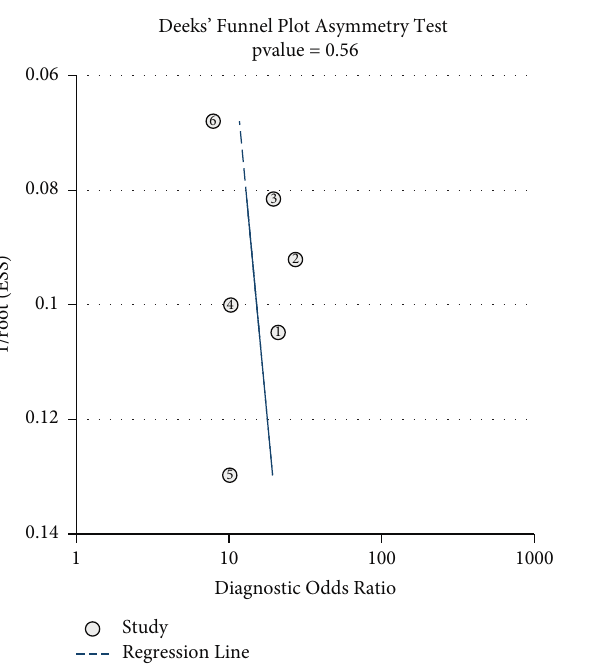
Figure 4: Publication bias evaluating digital rectal examination as a diagnostic test for dyssynergic defecation. There was no evidence of publication bias ( P � 0 . 56 > 0 .